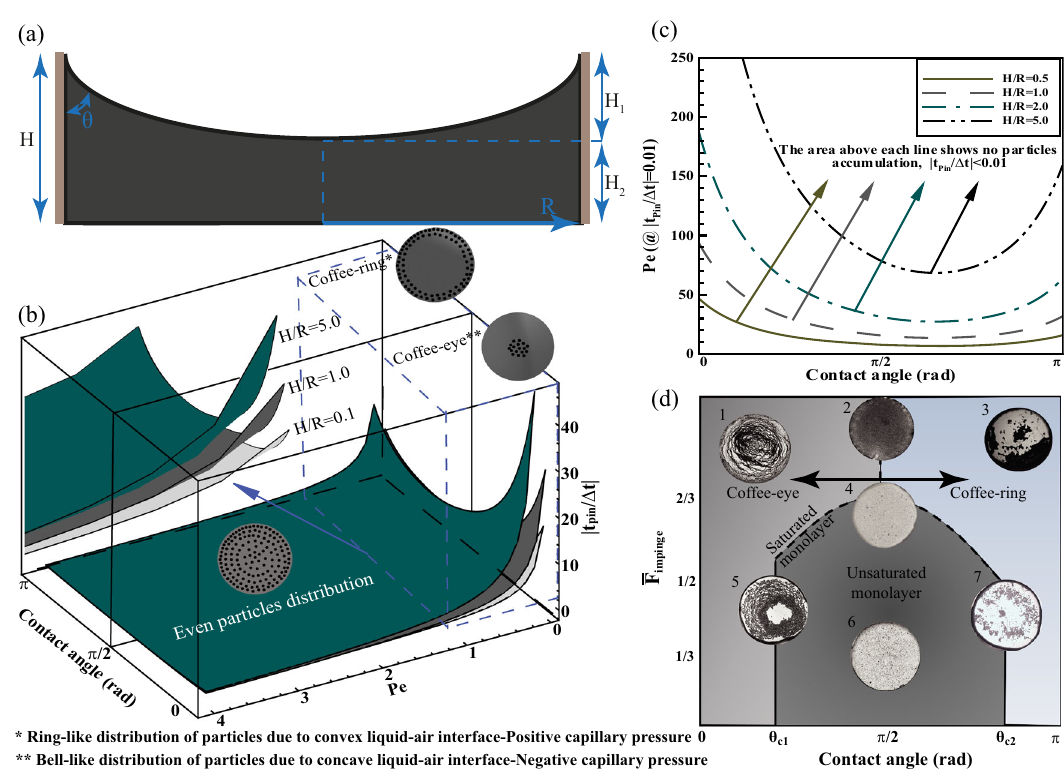
Fig. 5 Phase diagram for con fi ned particle-laden fi lm evaporation. a Schematic of the theoretical model, where R is the hydrodynamic radius of the mold, θ is the contact angle ranging from 0 to π , and H = H + H fi lm. b 3D phase diagram of different regimes of particle deposition for 1 2 is the height of the various H/R ratios, in which the distribution of particles on a superhydrophilic solid surface is dependent on the Peclet number of particles ( Pe ) and θ . The θ value represents the deposition morphology, where it creates a ring-like structure when θ > π = 2 and a bell-like structure when θ < π = 2. Low values of Pe intensify the accumulation of particles because of the higher diffusion rate of particles. An even particle distribution occurs when Pe is high, and θ tends to (cid:4) (cid:4) (cid:4) (cid:4) π /2. c The Pe number as a function of θ for t = 4 t < 0 : 01, assigning the no-coffee-ring and no-coffee-eye area (safe zone) at different H/R ratios. d 2D Pin phase diagram along with experimental data showing the monolayer, coffee-ring, and coffee-eye areas as a function of (cid:2) F impinge and θ . The (cid:2) F impinge and θ (cid:5) 0 : 72, θ ≈ 54°; (2) (cid:2) F (cid:5) 0 : 9, θ ≈ 90°; (3) (cid:2) F (cid:5) 0 : 86, θ ≈ 106°; (4) (cid:2) F (cid:5) 0 : 6, θ ≈ 90°; (5) values for the experimental data are (1) (cid:2) F impinge impinge impinge impinge (cid:2) F (cid:5) 0 : 42, θ ≈ 54°; (6) (cid:2) F (cid:5) 0 : 35, θ ≈ 90°; and (7) (cid:2) F (cid:5) 0 : 5, θ ≈ 106°. Source data are provided as a Source Data fi impinge impinge impinge